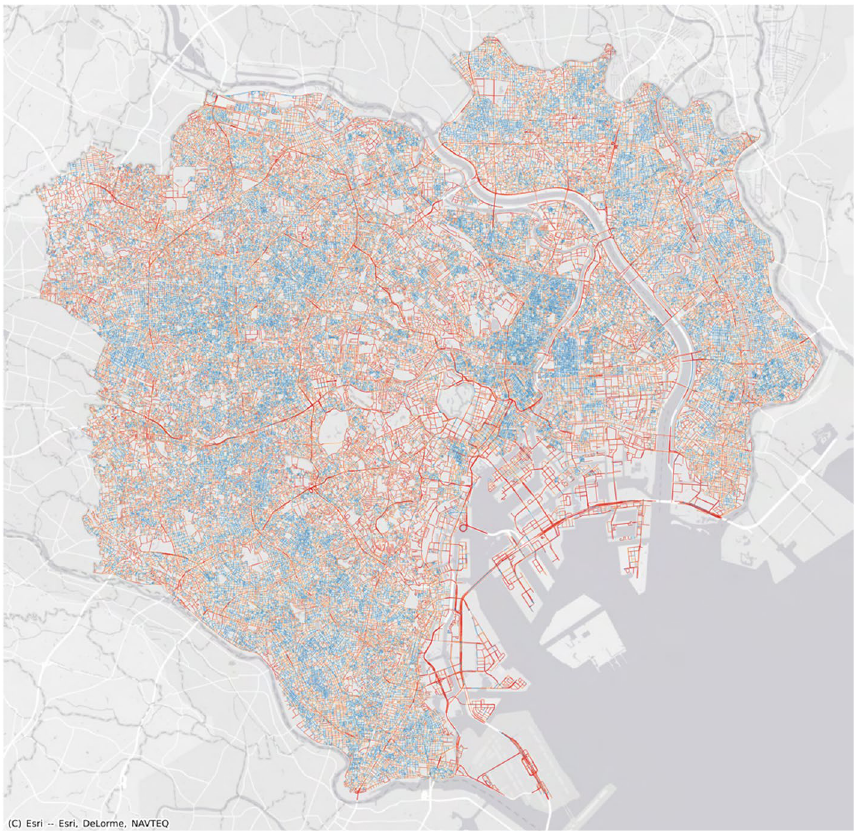
Fig. 9 Map of the edge weights capturing node similarity among all variables using ω 2 , 400 m subgraphs, and only road features. Dark red indicates minimal similarity, dark blue indicates the max similarity, colors diverge at the mean similarity value. Fairly large collections of similar nodes appear throughout the